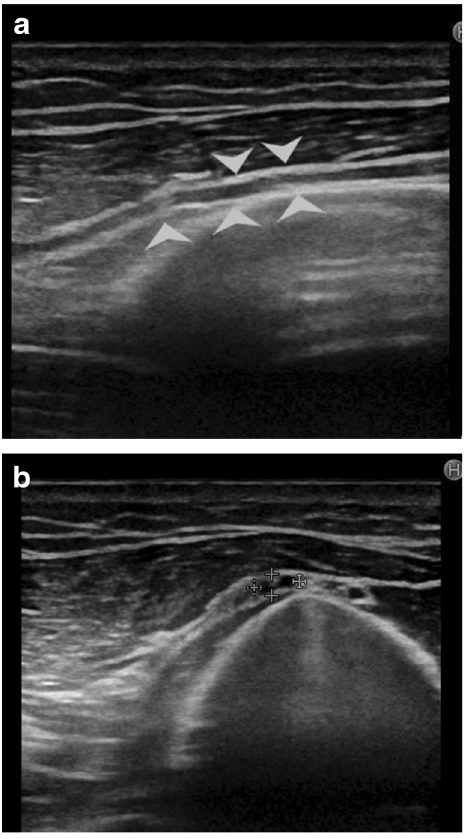
Fig. 10 a Loss of normal honeycomb pattern is seen in this patient who had a tourniquet placed for forearm surgery. The patient had wrist drop in the post-operative period which has improved gradually over 3 months with physiotherapy but has not recovered completely. b Short axis view of radial nerve in spiral groove, between cross heads. The nerve is hypoechoic but of normal calibre